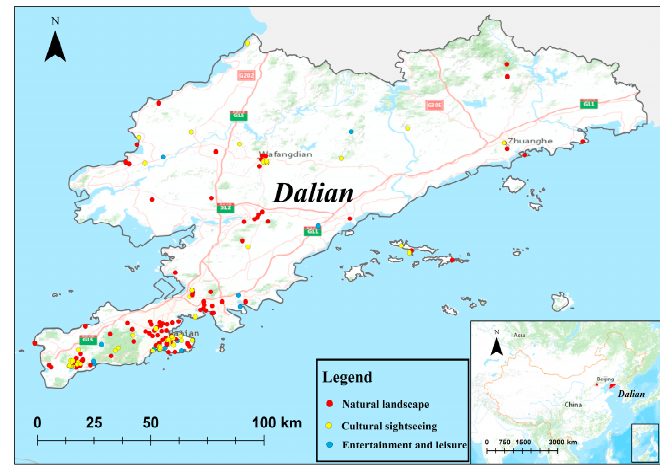
Figure 5. Distribution of major tourism attractions in Dalian.